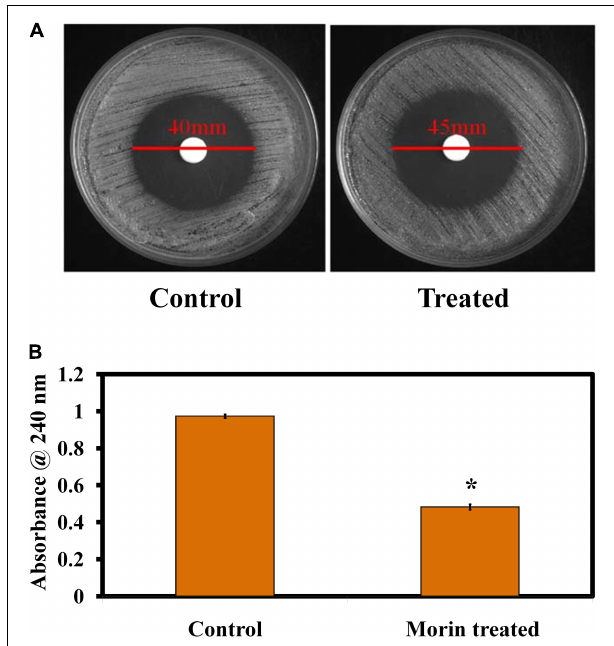
FIGURE 6 | (A) Effect of morin (at MBIC) on C. albicans catalase production. (B) Quantitative analysis of the catalase inhibitory activity of morin (at MBIC).